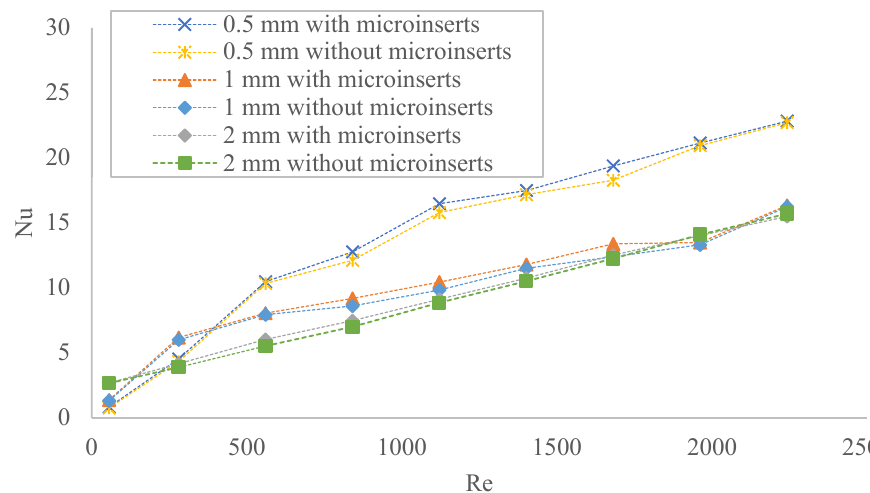
Figure 8. Variation of Nusselt number as a function of Reynolds number.